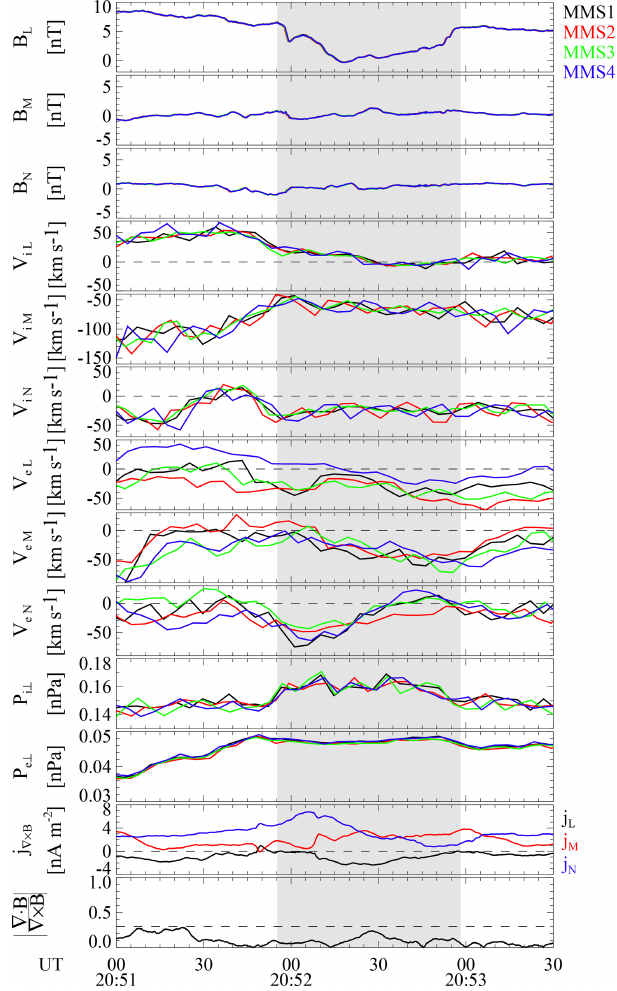
Figure 4. From top to bottom: three components of the magnetic field, ion and electron velocities in LMN, the ion and electron per- pendicular thermal pressures, the current density in LMN, and the ratio of |∇· B | / |∇× B | between 21:01 and 21:05UT. The black, red, green, and blue colors indicate data obtained from MMS1, MMS2, MMS3, and MMS4, respectively. The current density is calculated by the curlometer technique. The gray region indicates the interval of the magnetic